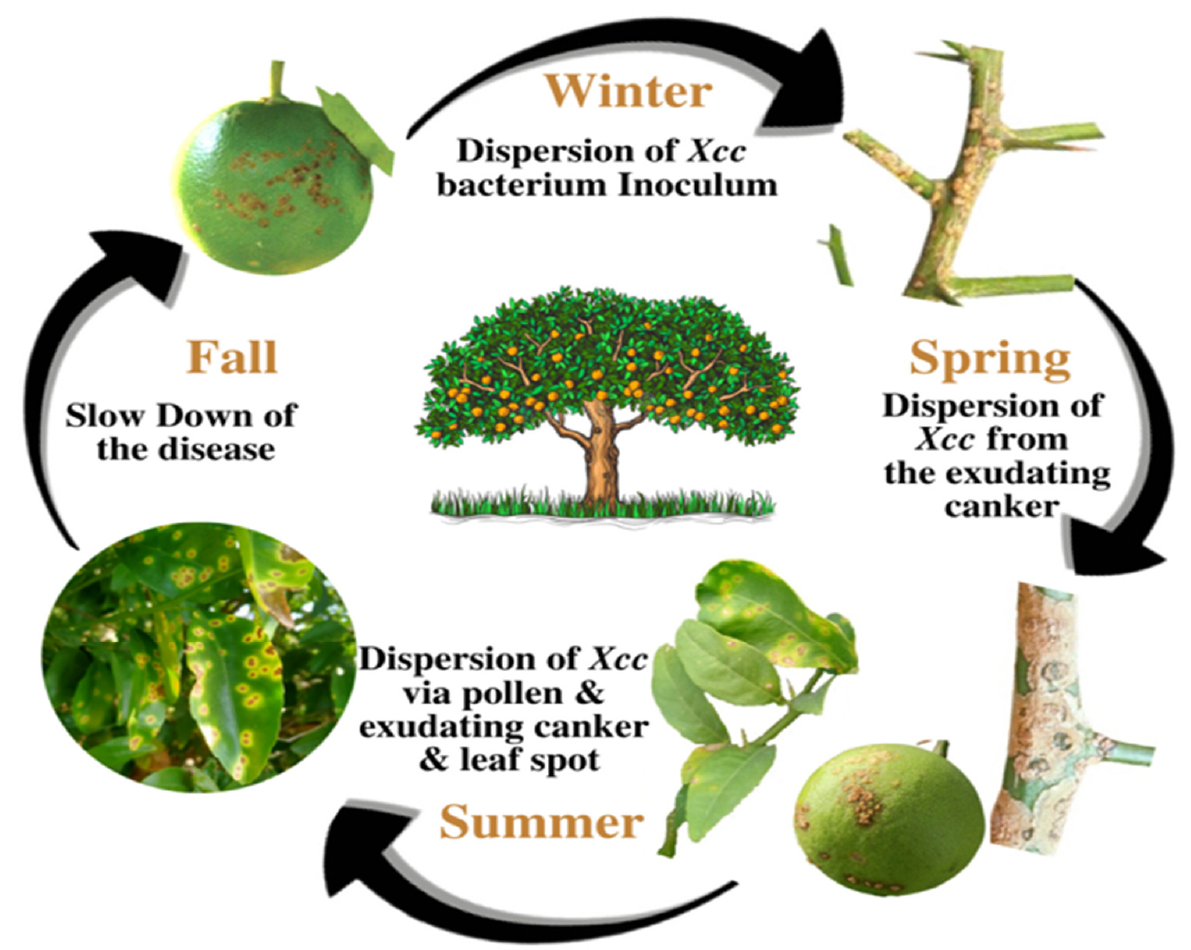
Figure 5. Dispersal of Xanthomonas citri subsp. citri in orchards over different seasons—like in spring (Dispersion of Xcc from exudating canker), summer (Dispersion of Xcc via exudating canker and leaf spot), fall (slowdown of disease occurred), and winter (dispersion of Xcc inoculum takes place)—round the year.